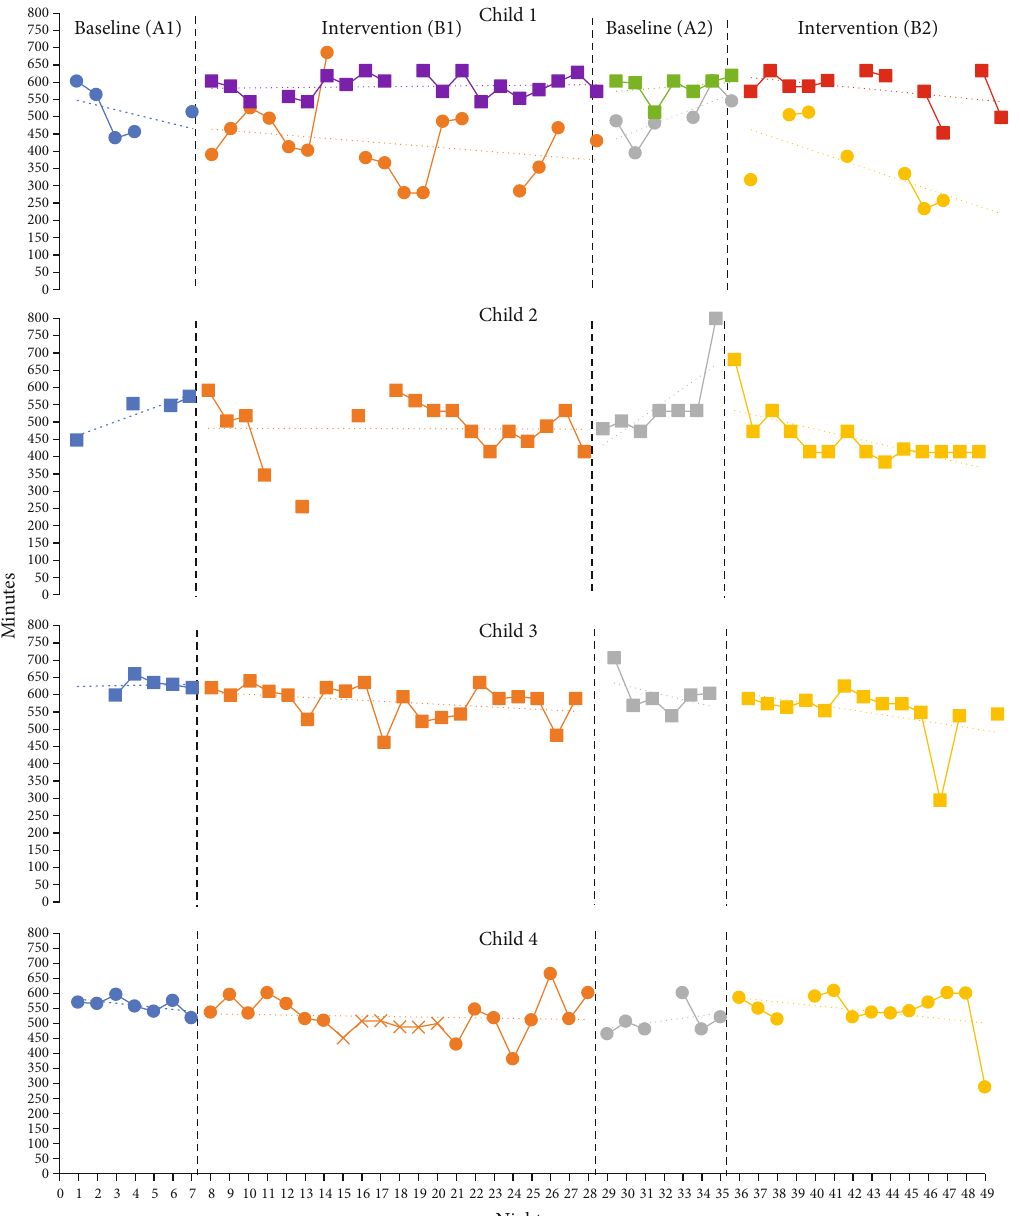
Figure 2: Sleep duration. Note . Garmin data is identi fi ed by a circle. Sleep log data is identi fi ed by a square. Child 4 spring break is marked by an X during intervention (B1). We did not input missing